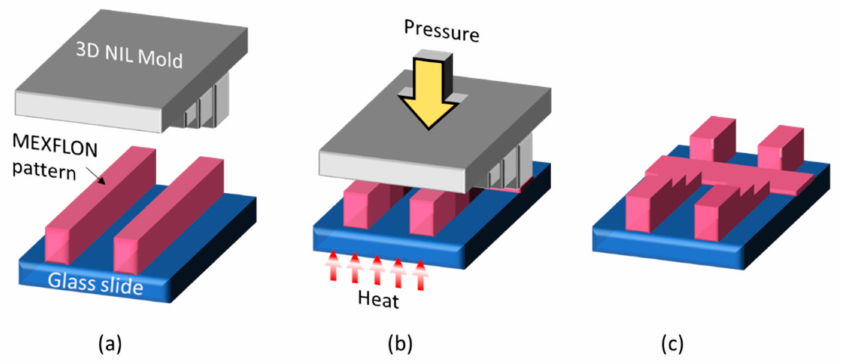
Figure 5. Three-dimensional calibration-plate fabrication process for TIRFM with RIM: ( a ) a nanoim- print mold having a 3D structure is positioned; ( b ) thermally nanoimprinted; ( c ) a MEXFLON pattern having a 3D structure after cooling to room temperature.